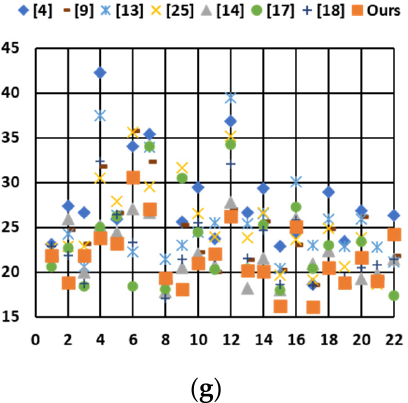
Figure 11. Comparison of scatter plots using the twenty-two test images, where the horizontal axis indicates the image order, and the vertical axis indicates the objective quality index. ( a ) Result of TMQI-S. ( b ) Result of TMQI-N. ( c ) Result of TMQI-Q. ( d ) Result of FSITM-TMQI. ( e ) Result of BRISQUE. ( f ) Result of BTMQI. ( g ) Result of IL-NIQE.